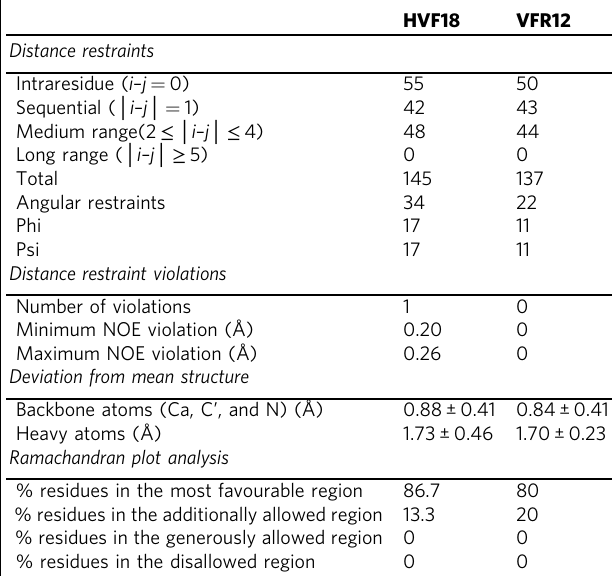
Table 1 Summary of the structural statistics for the 20 lowest energy structures of HVF18 and VFR12 in LPS